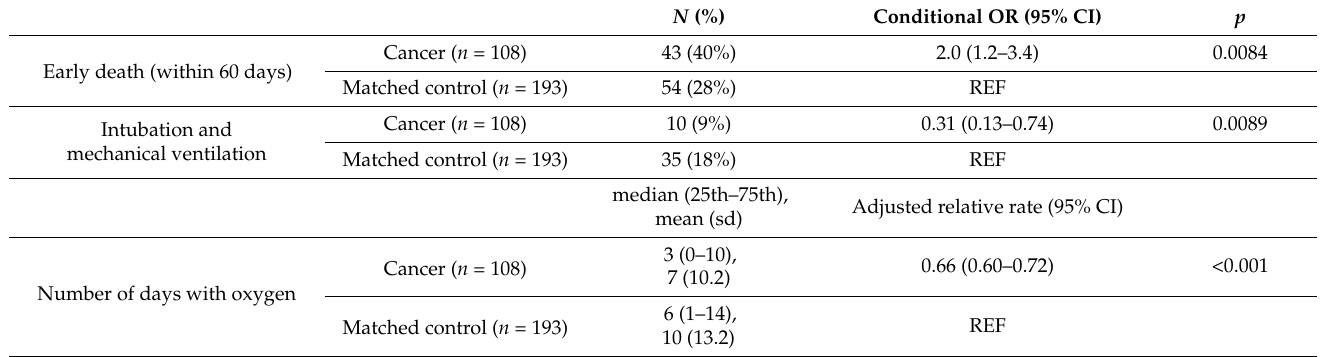
Table 3. Patient outcomes in the cancer and matched control